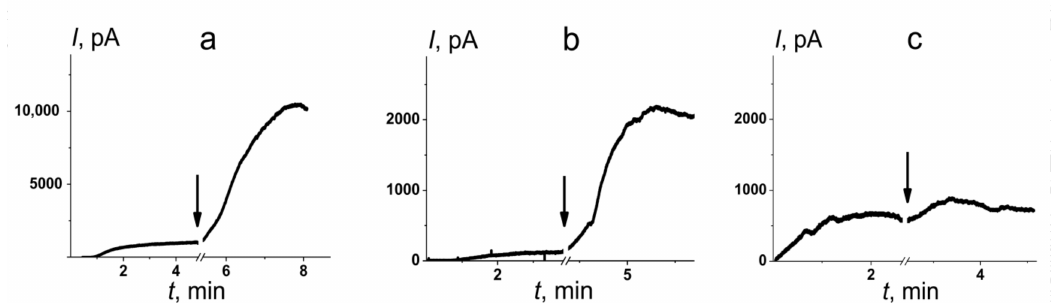
Figure 4. The effects of PDE-5 inhibitors on the steady-state transmembrane current induced by one-side addition of Nys. The moments of the addition of 100 µ M of sildenafil ( a ), vardenafil ( b ), or tadalafil ( c ) to the bilayer bathing solution are indicated by arrows. The lipid bilayers were composed of POPC/Chol (67/33 mol%) and bathed in 2.0 M KCl, pH 7.4 ( V = 50